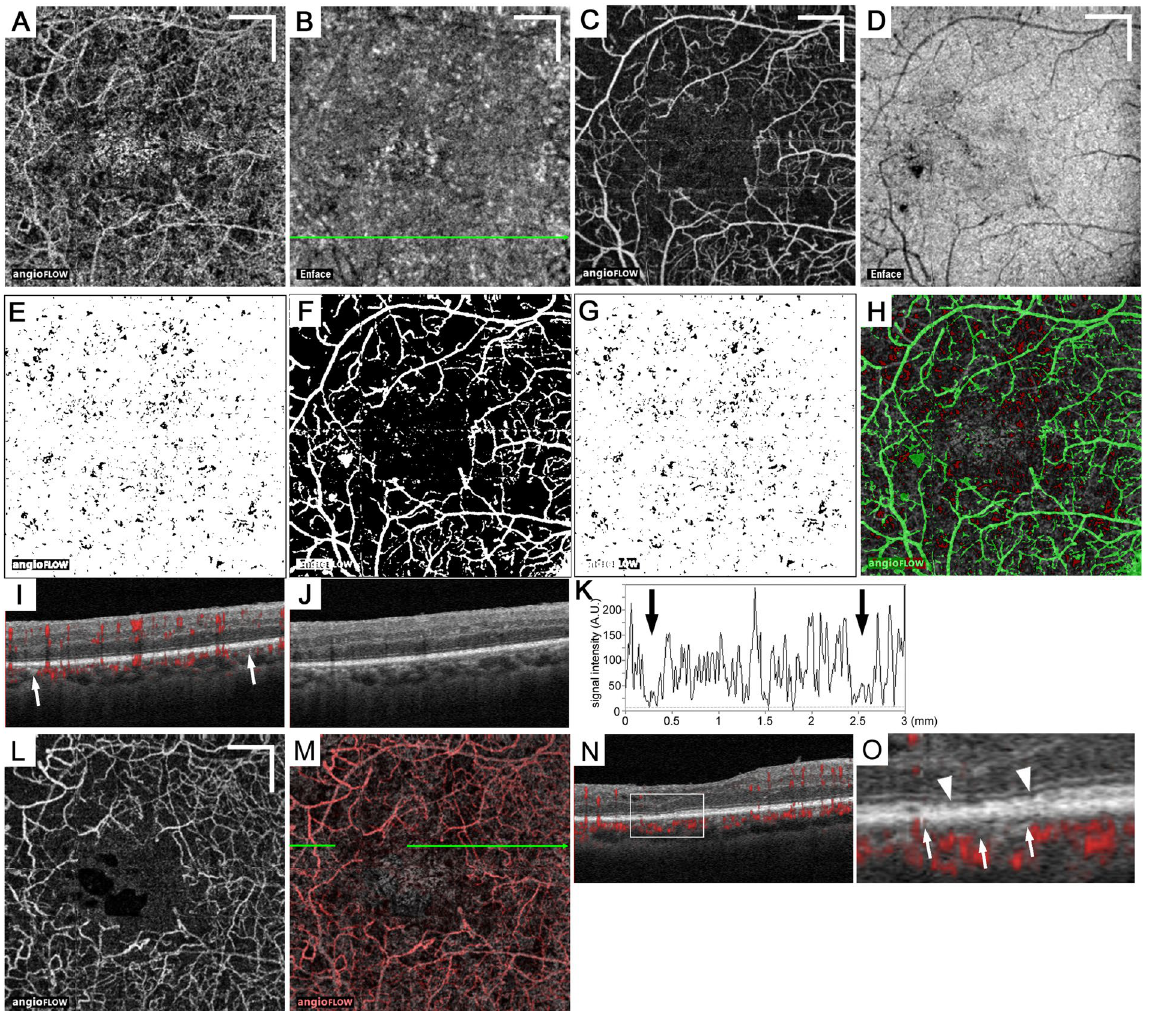
Figure 4. Larger lesions with reduced decorrelation signals in the choriocapillaris slab in a 68-year-old patient with PDR. ( A , B ) The 10- μ m-thick en-face OCTA and structural OCT images in the choriocapillaris layer. The en-face OCTA image in the superficial retinal layer ( C ) and the structural OCT image at the RPE level ( D ). ( E ) The binary image of panel A using the mean decorrelation signal in the outer retina as the cutoff value. ( F ) The binary image of the projection artifacts and/or shadow artifacts created from panels C and D. ( G ) The binary image of the areas of flow void after the removal of the areas with the artifacts. ( H ) The merged image of panel A (grayscale), ( G ) with inverted signals (red), and the binary image of artifacts ( F ; green). ( I , J ) B-scan images with and without decorrelation signals (red) along the green arrow in ( B ). ( K ) The intensity of the decorrelation signals along the green arrow in ( B ). ( L ) The en-face OCTA image in the deep retinal capillary layer. ( M ) The merged image of panels A (grayscale) and L (red). ( N , O ) The sectional image along the green arrow in panel M and its magnified image demonstrate that the EZ line is not intact in the areas of flow voids in both the retinal and the choroidal capillaries (between the arrowheads). ( O ) The white or black arrows in ( I , K , and O ) indicate the areas of flow void in the choriocapillaris layer. Scale bar = 500 μ